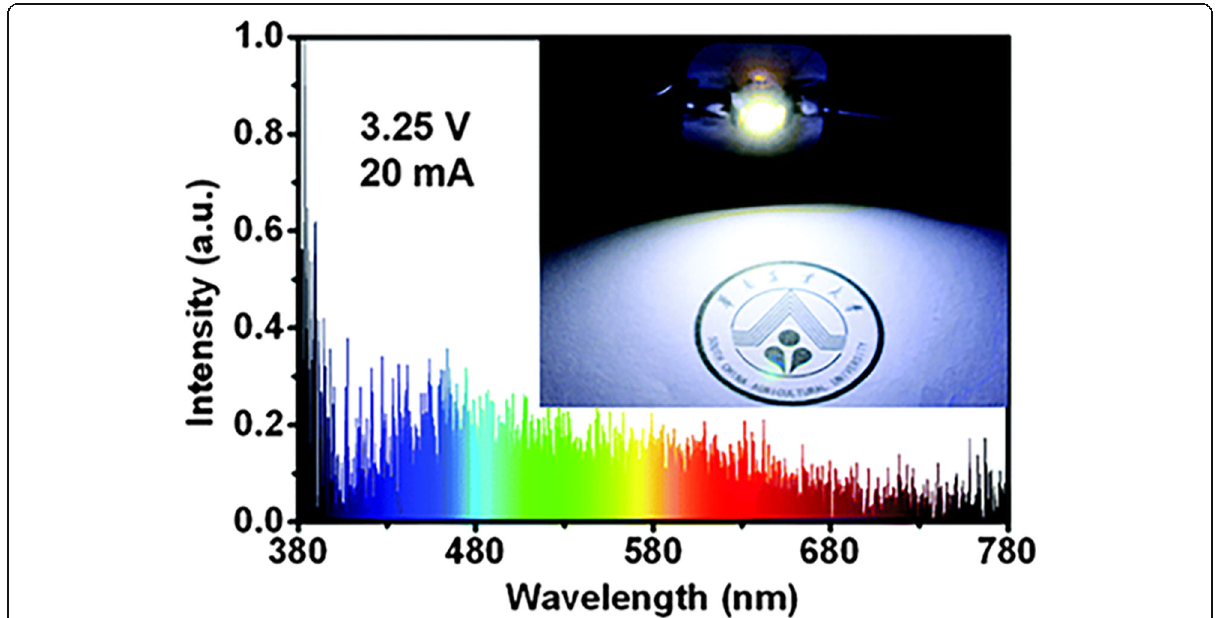
Fig. 6 The performances of CDSP-based WLED: emission spectra and photograph [42]